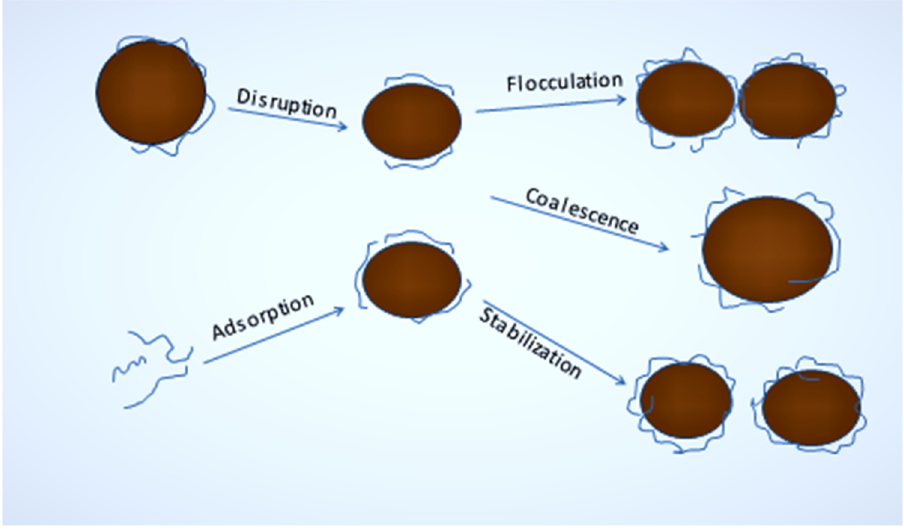
Figure 4. Overall views of instability emulsion [24].